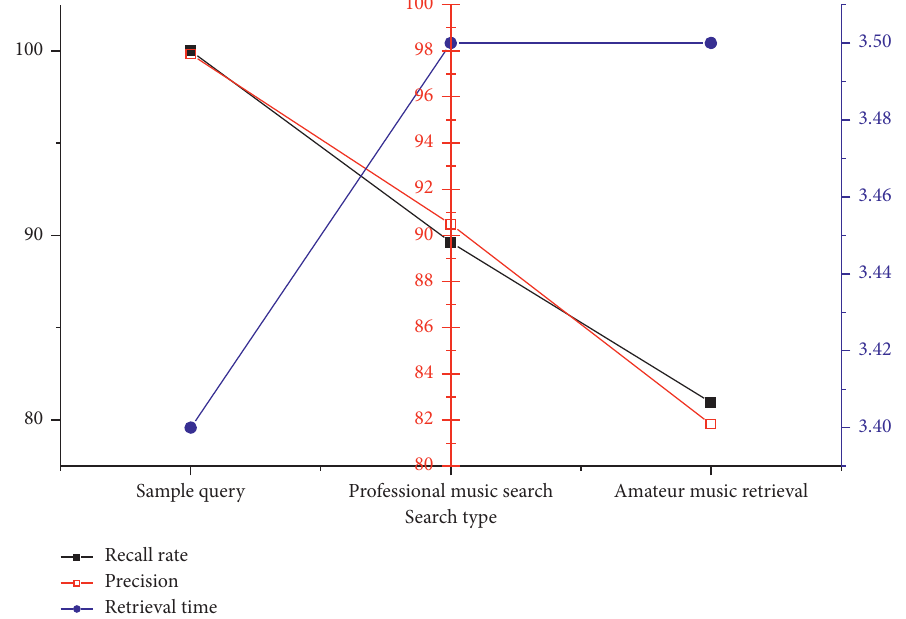
Figure 5: Search completion rate, search accuracy rate, and search time of the retrieval